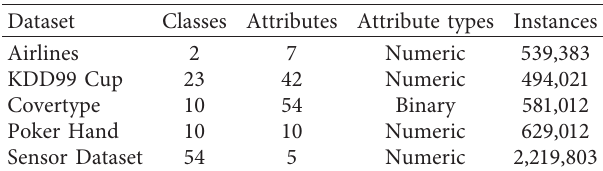
Table 1: Description of real-world